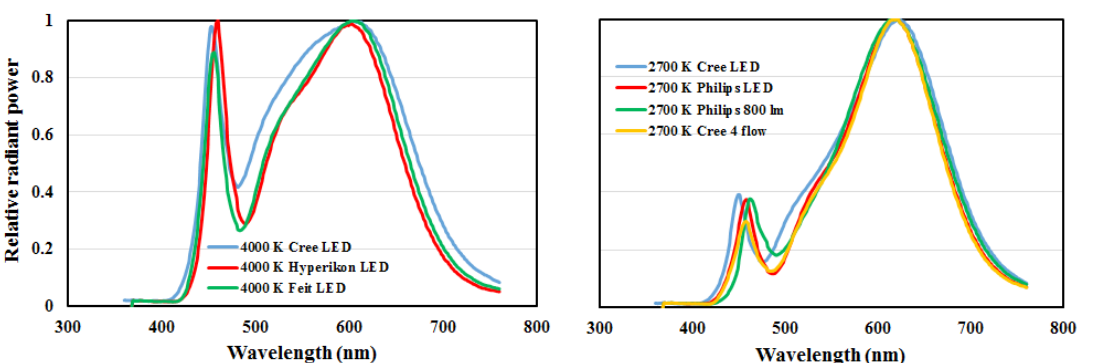
Figure 7. Comparing the spectral distribution of LEDs with the same CCT produced by different lighting companies